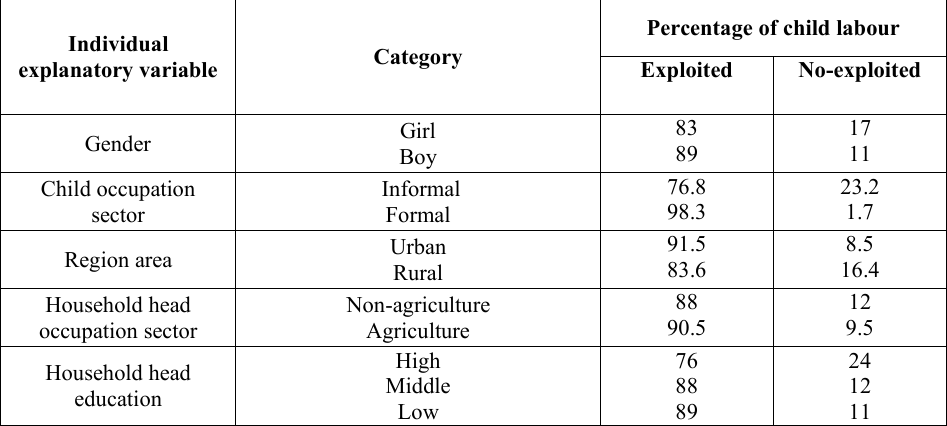
Table 1. Percentage of exploited child labour based on the categories of individual explanatory